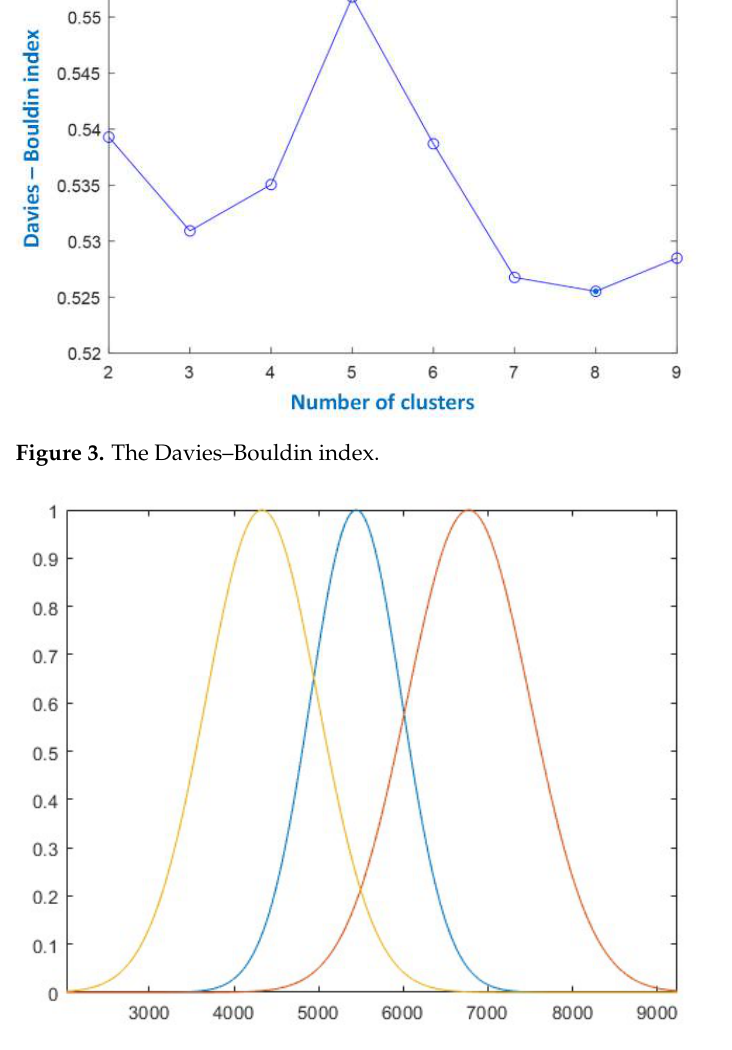
Figure 4. Input space partition by FCM.